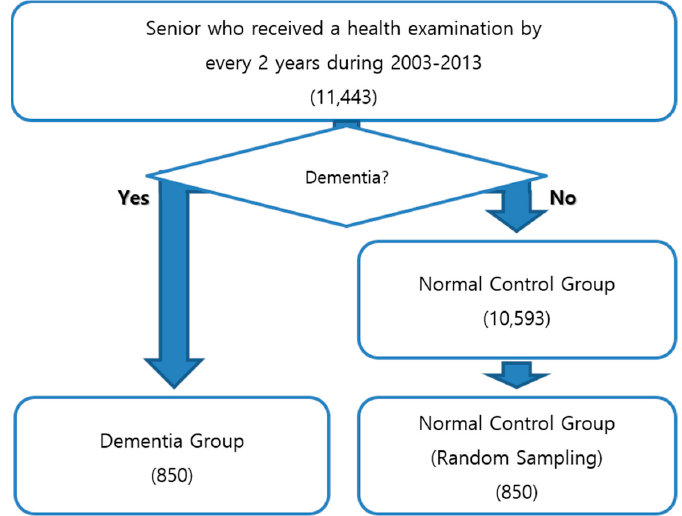
Figure 4. Data sampling process.